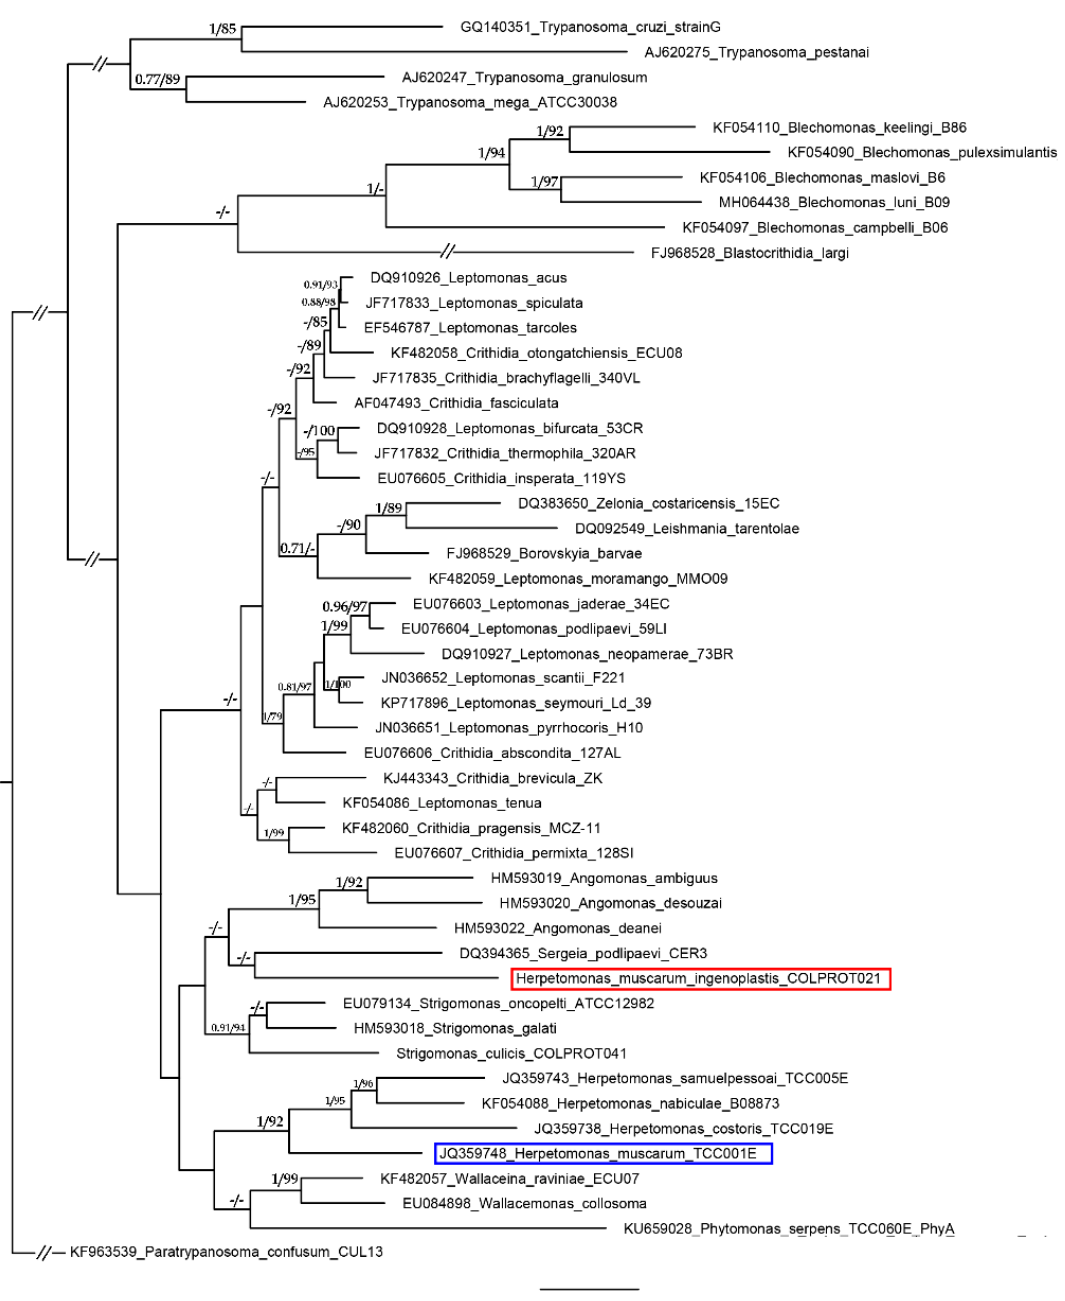
Figure 1. Phylogenetic analysis by ML and BI of H. muscarum ingenoplastis . The tree is based on the partial sequences of gGAPDH from COLPROT021 and GenBank sequences. The numbers at the top of each node denote Bayesian posterior probability and maximum likelihood bootstrap values. Dashes (-) indicate bootstrap support below 70% or different topology. The tree was rooted with the sequences from Paratrypanosoma confusum . Double-crossed branches are at 50% of their original lengths. The scale bar denotes the number of substitutions per site.